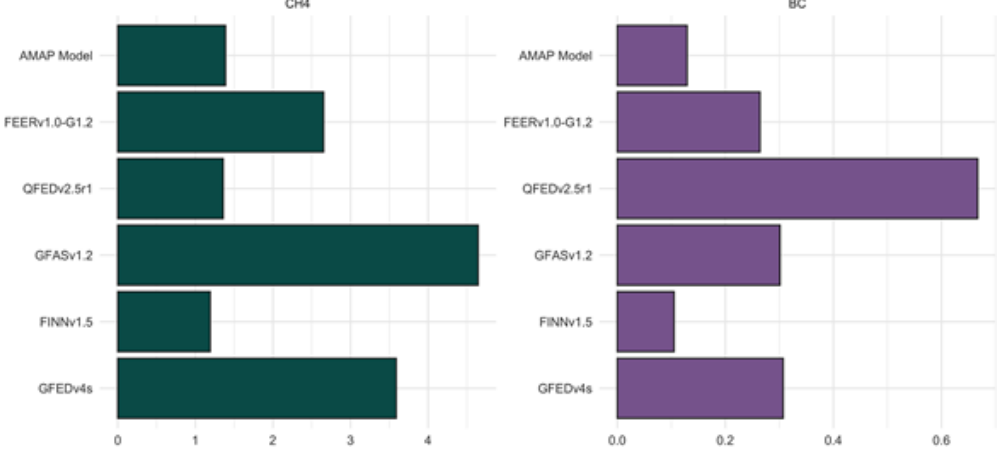
Figure 3. Annual 2018 BC and CH 4 emissions in teragrams from five global fire emissions models and a custom AMAP fire emissions model for north of 45 ◦ N. Table 1. Summary table of BC, PM 2 . 5 , and CH 4 emissions in teragrams (Tg) from reported statistics on burned area from the Arctic Council members; sources for burned area include Norway (DSB, 2020), Greenland (Markuse, 2019), Finland (Ketola, 2020), Sweden (Betänkande av 2018 års skogsbrandsutredning, 2019), Canada (CIFFC, 2020), Alaska (Alaska Division of Forestry, 2020), the contiguous United States (NIFC, 2019), and the Russian Federation (Aviales, 2019). Fuel loadings and combustion completeness are from Van Leeuwen et al. (2014) for boreal forests, with tundra values used for Greenland and temperate forests for the USA/CONUS; emission factors are taken from GFED4. Country/